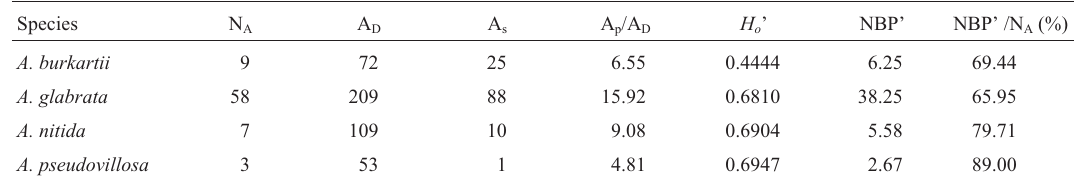
Table3 -Statisticalanalysisofthedatafor77accessionsofthefour Arachis speciesinsection Rhizomatosae ,showingthenumberofaccessions(N A ),to- tal alleles detected (A D ), number of specific alleles (A s ), ratio of putative alleles (A p ) to total alleles detected (A p /A D ), general mean observed heterozygosity per species ( H o ’), mean number of different band patterns (NBP’) and percentage of different band patterns per number of accessions (NBP’ /N A ,